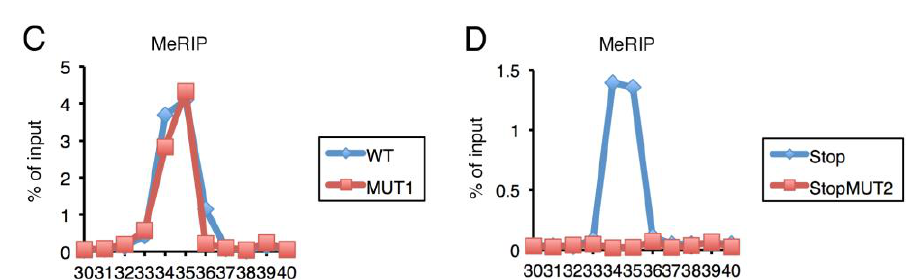
Figure 2. Identification of m 6 A sites in HBV RNA. ( A ) Sequence alignment of the region for predominant m 6 A modifications (#34 and #35) in HBV (C_JPNAT (genotype C), AD38 (genotype D), and other genotypes) and Woodchuck hepatitis viruses (WHV1 and WHV2). Asterisks denote possible m 6 A sites. Red letters indicate conserved consensus motifs. ( B ) Mutagenesis of possible m 6 A sites. Mutated nucleotides were indicated by underlines. The AAG sequence upstream of A1662 was modified to UAG to change the codon to Stop. ( C , D ) HepG2/NTCP cells were transfected with pUC1.2xHBV with the indicated mutations, incubated for 2 days, and subjected to MeRIP analysis, which was followed by qRT-PCR.